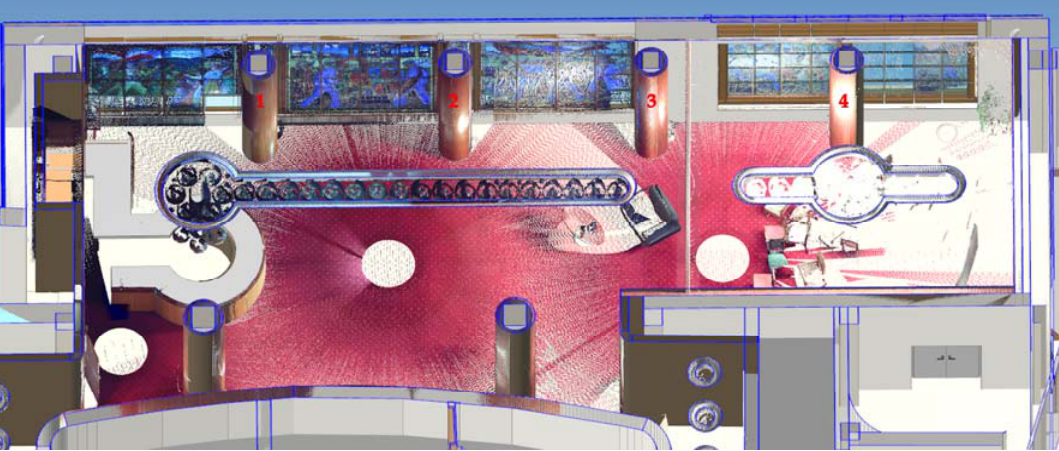
Figure 15. DPOH—as-planned model (BIM) with the as-built point cloud and the numbering of the chosen elements (red color).